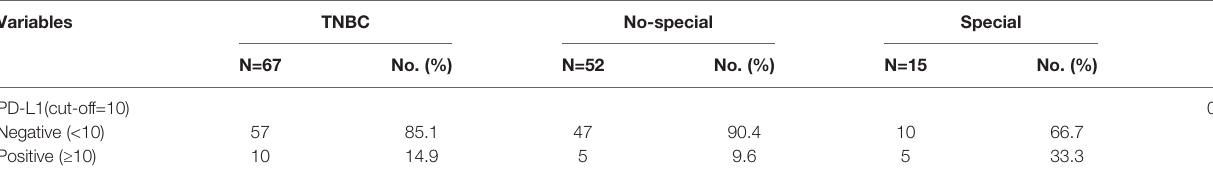
TABLE 2 | Characteristics of PD-L1 expression in the GDPH TNBC cohort (N=67).